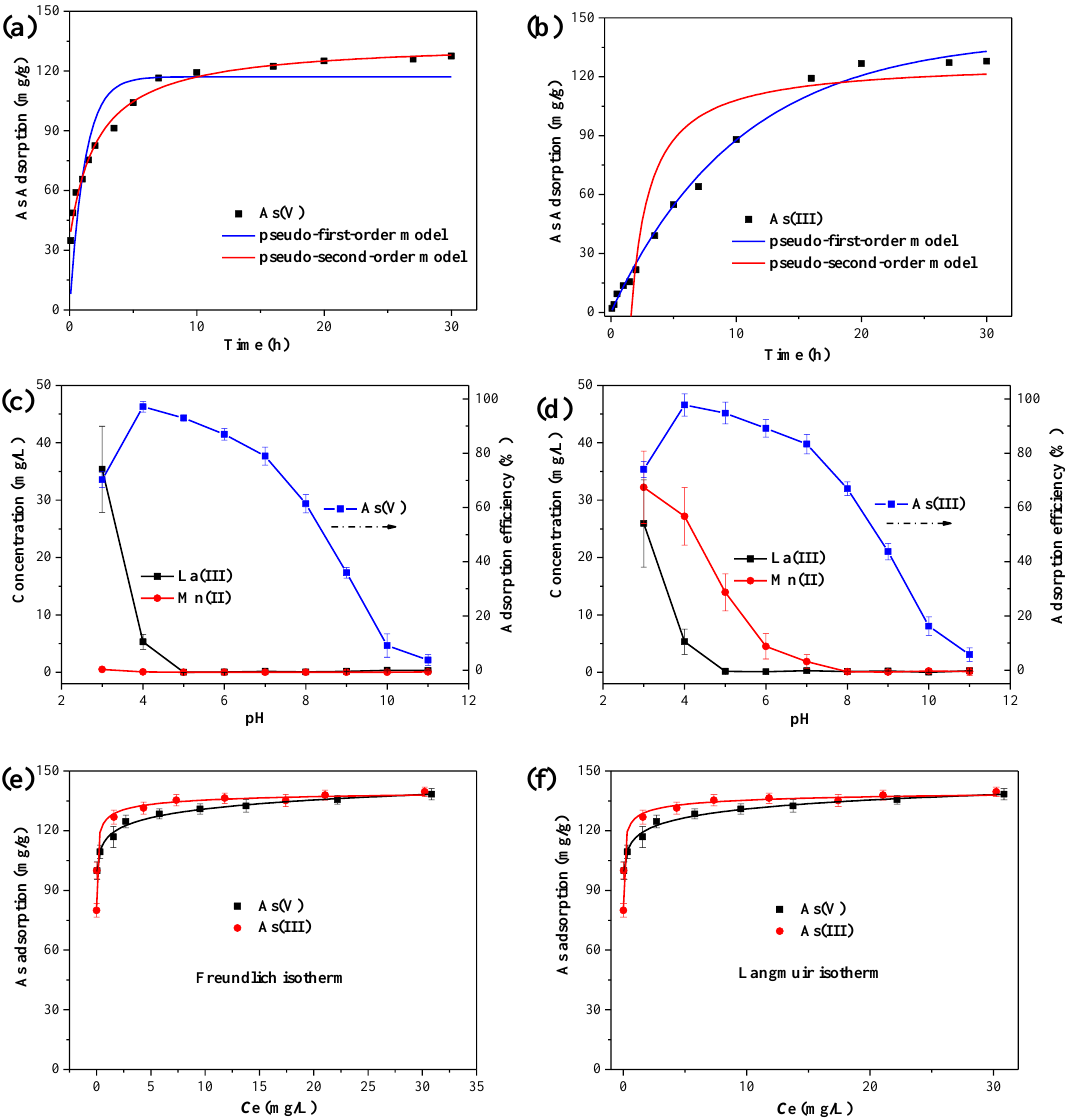
Figure 4. The influence of solution pH on As(V) ( a ) and As(III) ( b ) removal and the concentrations of La(III) and Mn(II) release at different pH conditions after As removal. The adsorption kinetics of As(V) ( c ) and As(III) ( d ) at pH 4.0. Adsorption isotherms at pH 4.0 with different initial As concentrations and their Freundlich ( e ) and Langmuir ( f ) fitting. Experimental conditions: the initial As concentration was 65 mg/L.